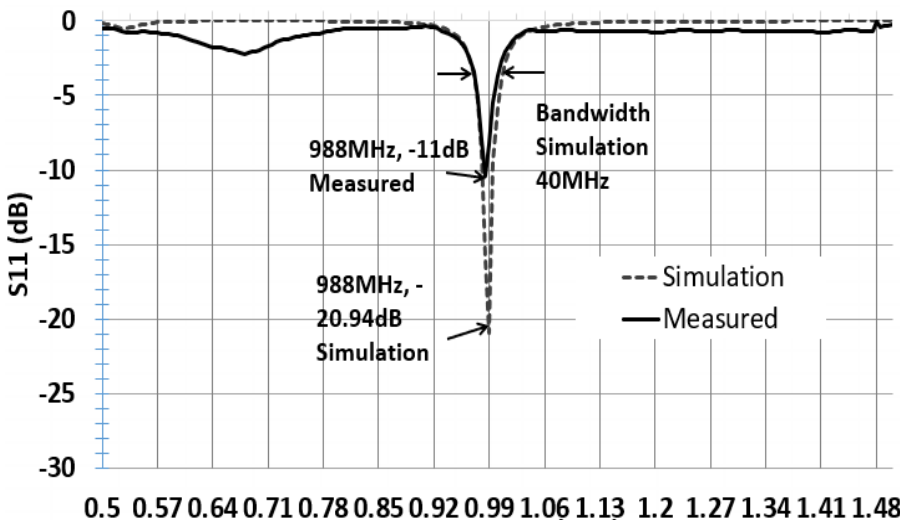
Figure 14. Simulated and measured S11 with parameter ant_h9 in Table 2. We measured the reading range with an Alien RFID reader with a linear polarized (LP) antenna, and a circular polarized (CP) antenna. Figure 15 shows the outdoor reading range pattern of the fabricated CTA with ant_h9 size measured using CP antenna. The measurement was performed by turning the antenna according to Phi and Theta angle directions. The backside of the antenna where there is metal shows a short reading range of 1 m at 180 degrees, while the front side shows the maximum reading range of about 36 m at 0 degrees. The simulated radiation pattern also shows that the maximum power of the antenna is obtained when the convex tag antenna faces the reader.